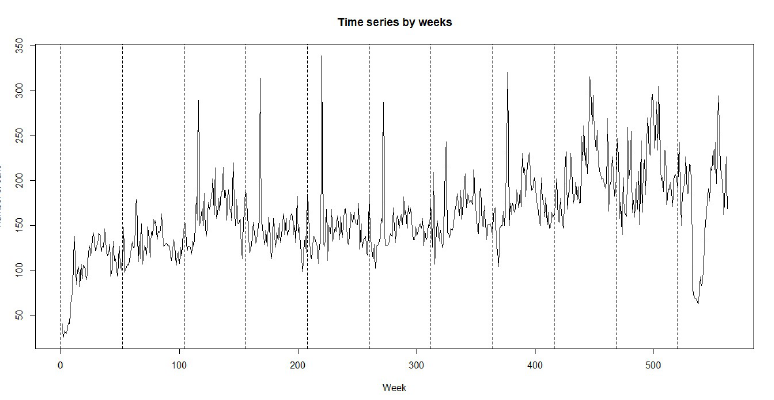
Figure 1. Time series by weeks of the 83,379 emergency calls in Valencia (2010–2019).